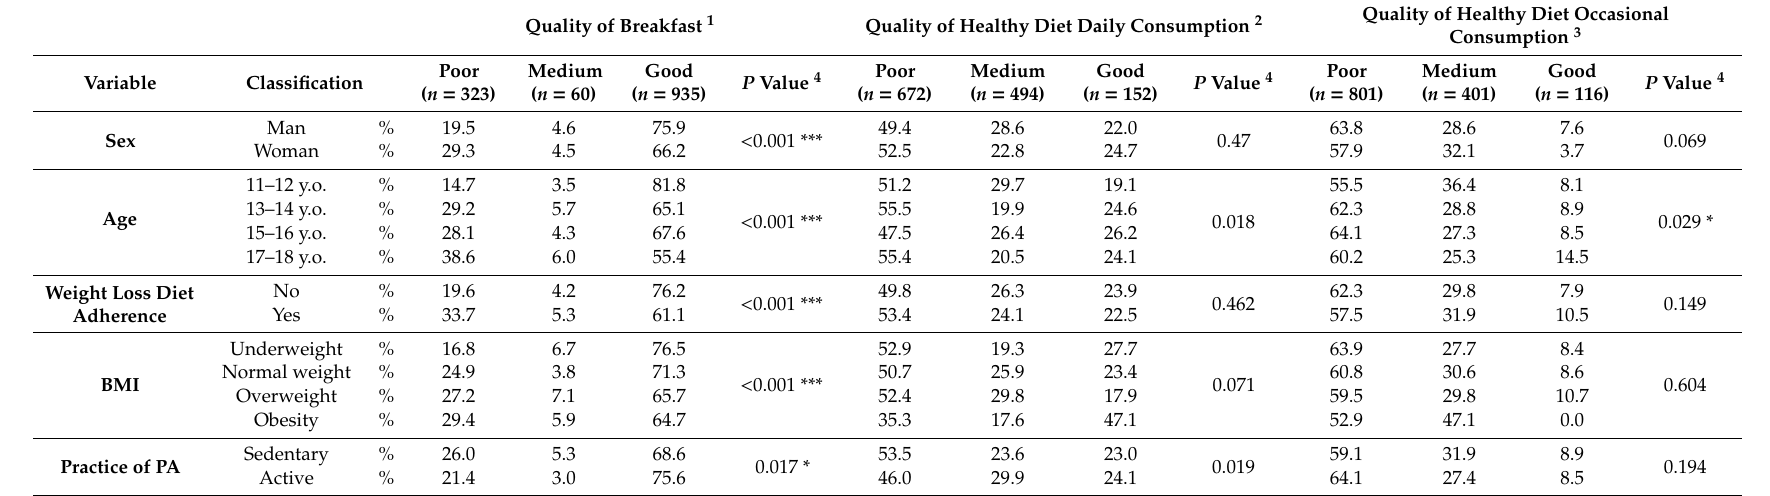
Table 1. Comparison of quality of breakfast and type of healthy diet by sex, age, weight loss diet adherence, BMI and practice of